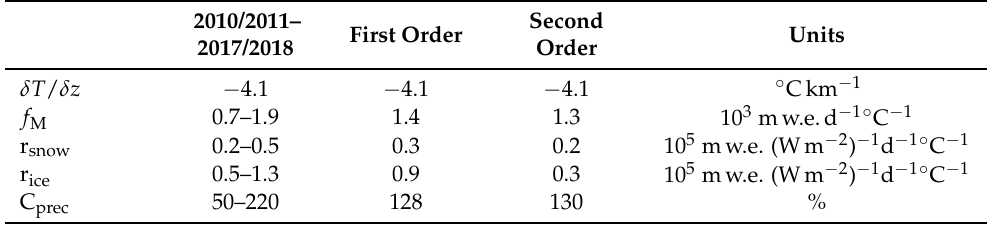
Table 1. Constant and calibrated model parameters after the different calibration steps (first- and second-order calibration steps). The parameters resulting from the second-order calibration were used to model the mass balance years from 1900/1901 to 2009/2010. Second First Order